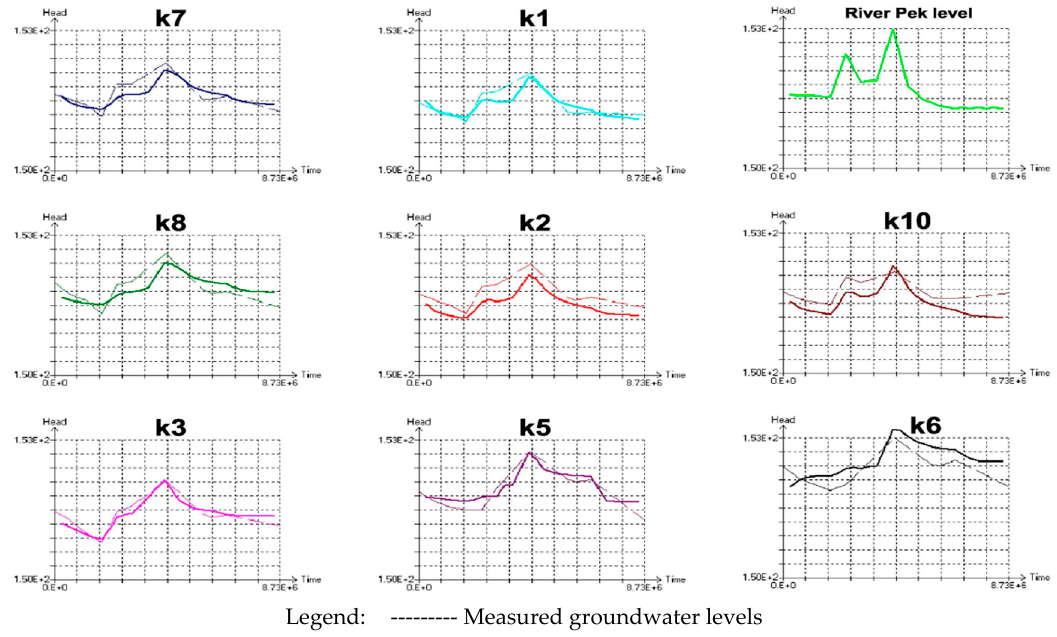
Figure 5. Model calibration results–parallel representation of measured and computed groundwater levels at select piezometers under transient conditions for the March–June 1997 period. Note: The ordinate shows the piezometric head in meters above sea level, and the abscissa shows the simulation time in seconds (in exponential